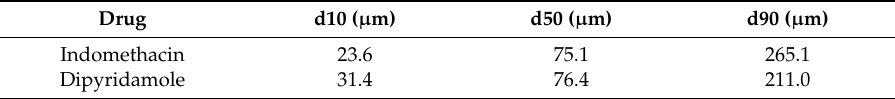
Table A2. Particle sizes of indomethacin and